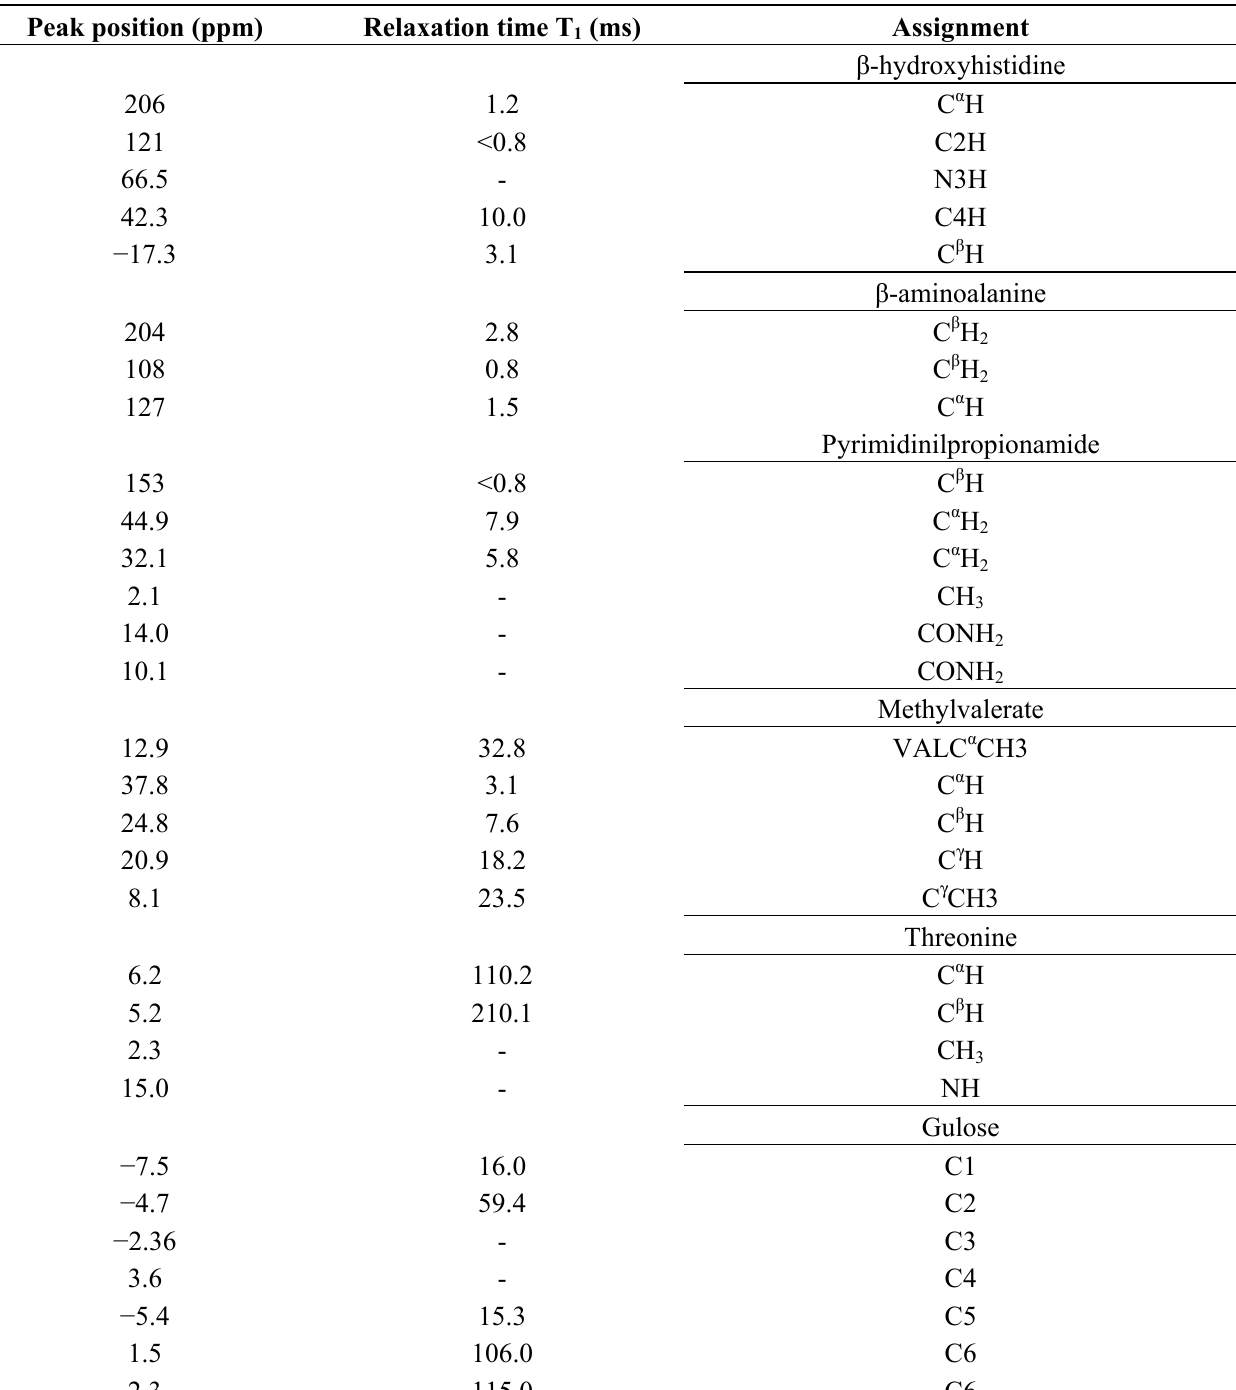
Table 1. Summary of the positions and relaxation times for the protons in Fe(II)BLM determined at 298